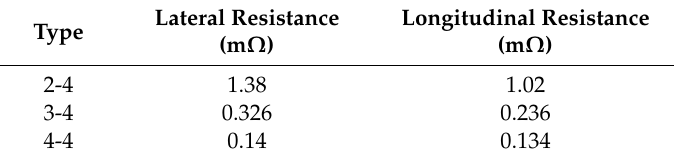
Table 7. Relationship between electroless times and composite coatings